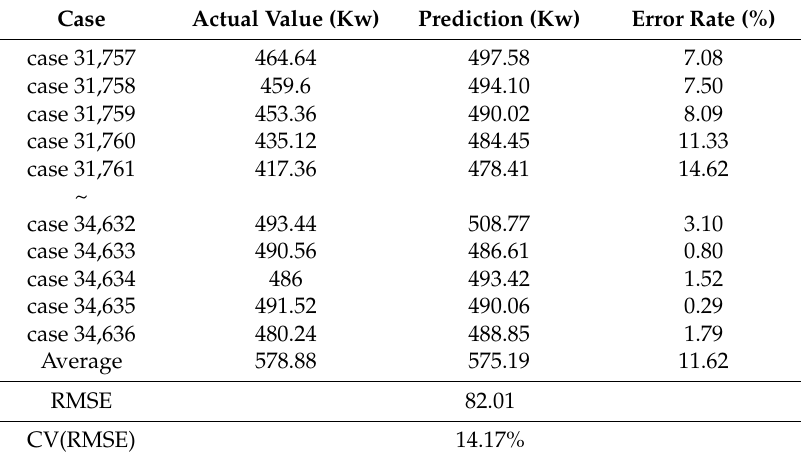
Table 3. Difference between the actual value and predicted